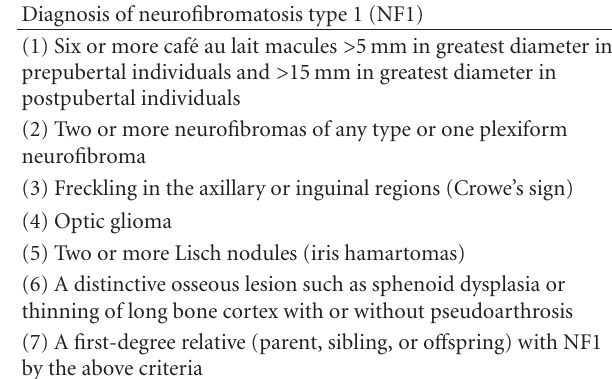
Table 1: National Institute of Health diagnostic criteria for neurofibromatosis type I [1]. The criteria are met in an individual if two or more of the features listed are